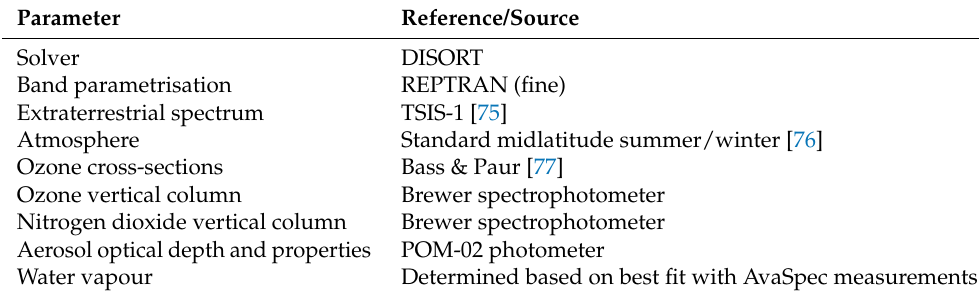
Table 1. Configuration of the radiative transfer